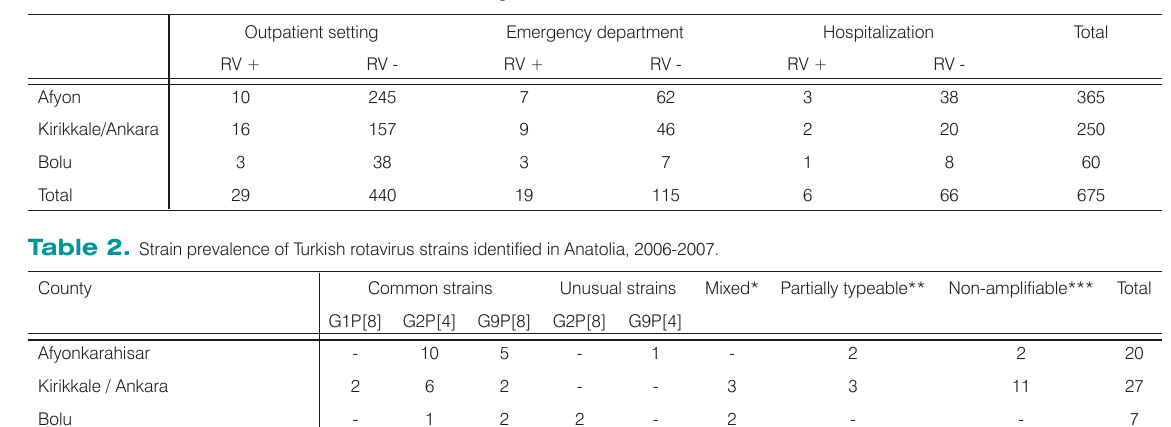
Table 1. Detection of rotavirus infections in various settings, Anatolia, 2006-2007.